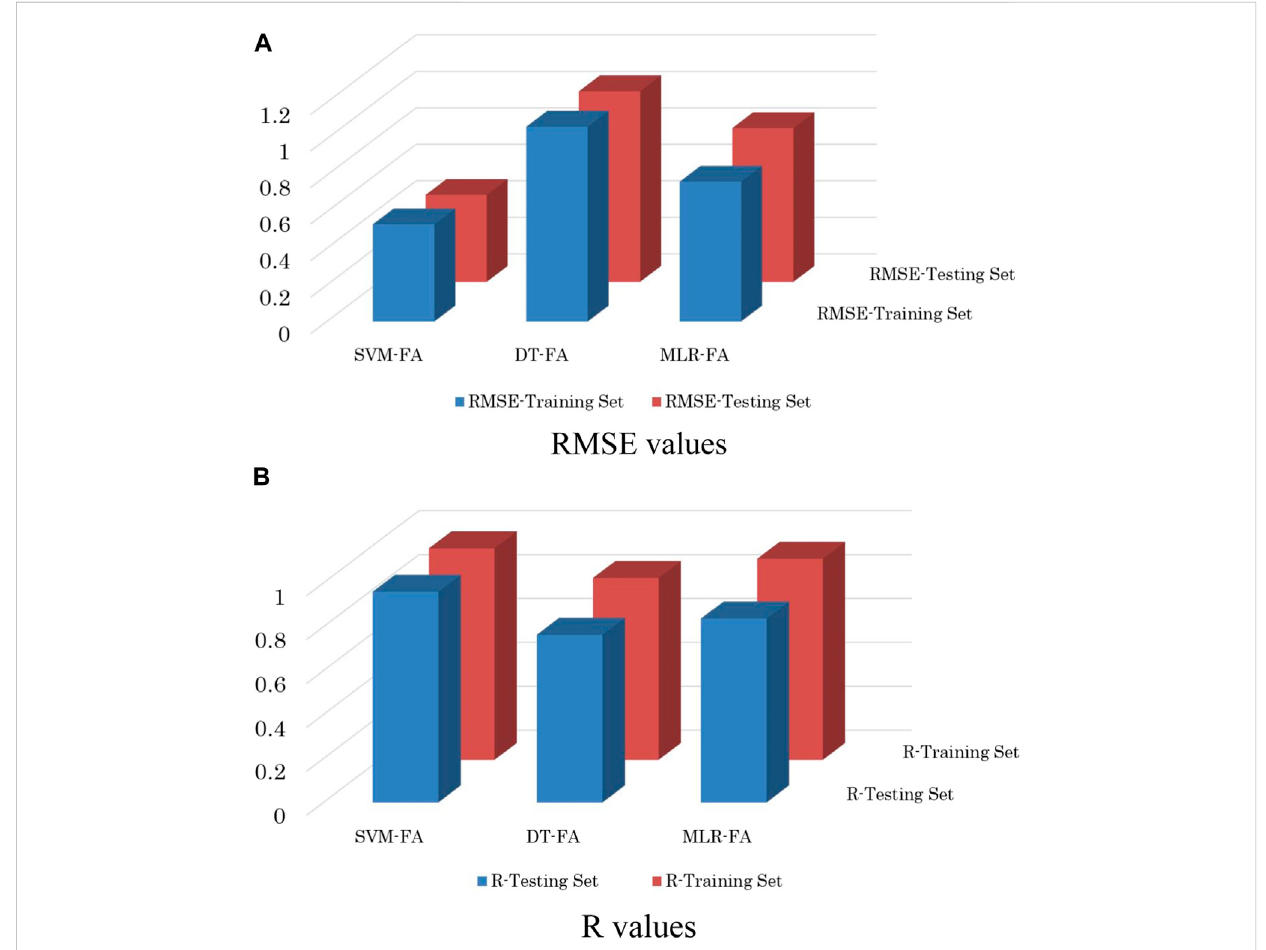
FIGURE 12 The R values and RMSE values of different hybrid machine learning models [ (A) : R values, (B) : RMSE values].